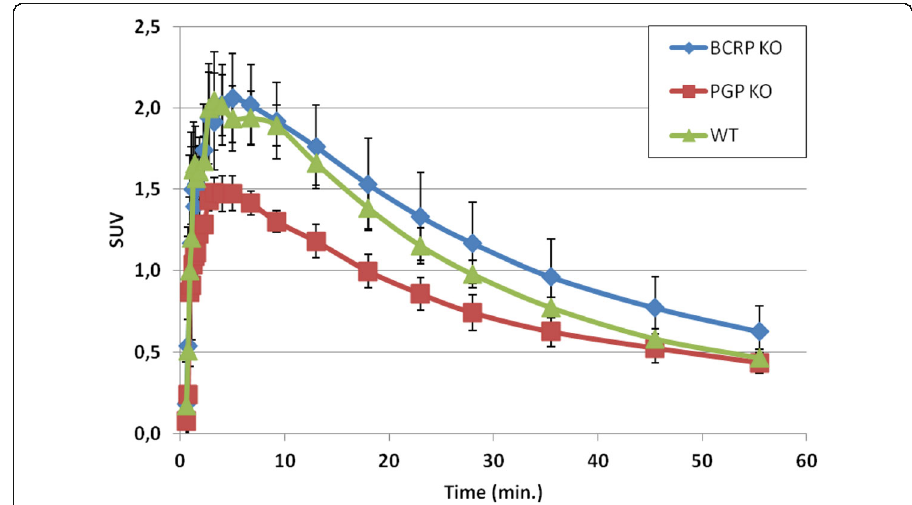
diamonds) and WT mice (green triangles)